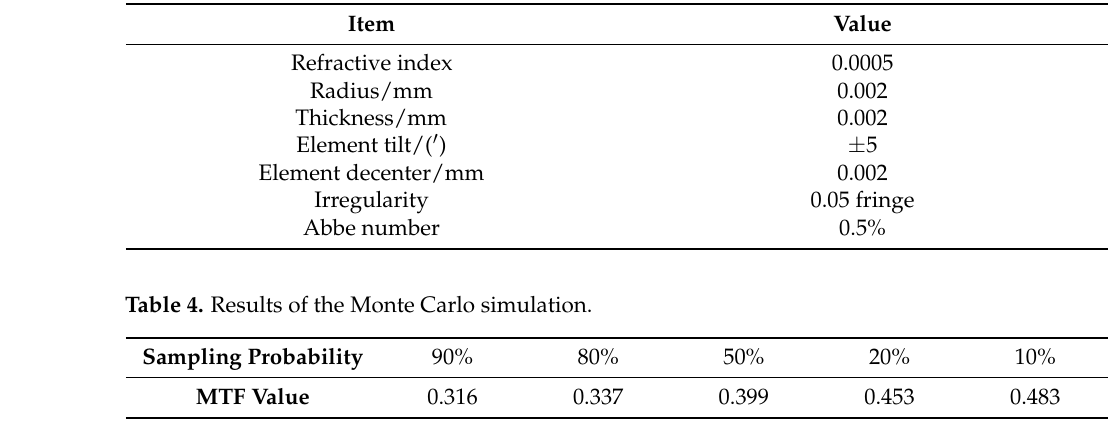
Table 3. Tolerance analysis items and their values.